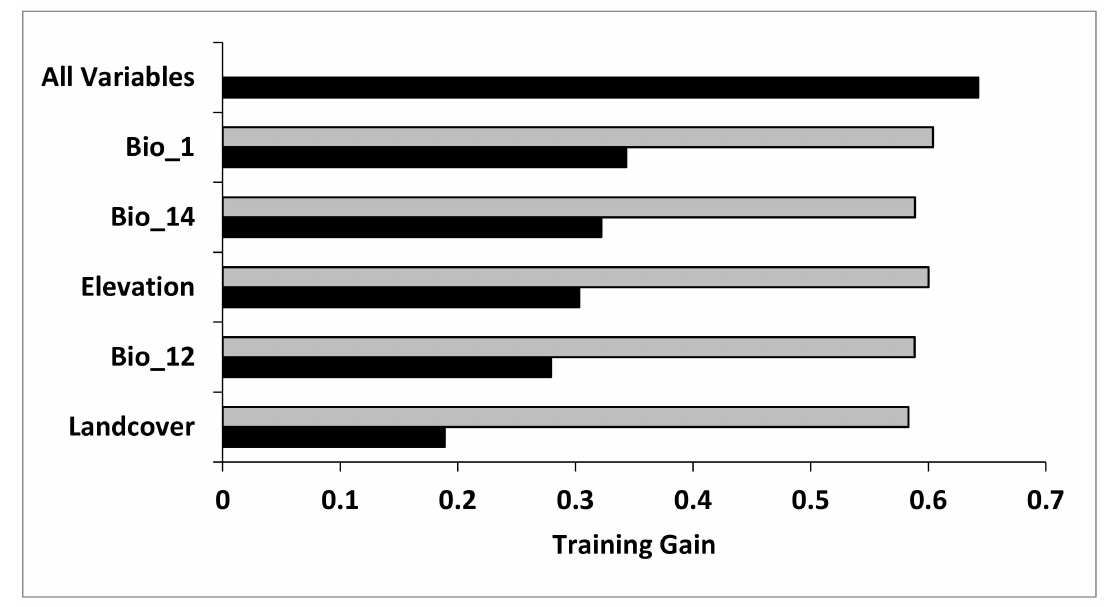
Figure 1. Jackknife test for evaluating the relative importance of predictor variables. (Annual mean temperature (Bio_1), Annual precipitation (Bio_12), Precipitation of driest month (Bio_14)). The average training gain gradually declined as variables were removed (Table 2). Test AUC values were significantly better than random (> 0.5 AUC) for all models (0.76–0.88), suggesting little model over-fitting. Using the overlap between 95% confidence intervals, both the average training gain and the average training AUC pointed to the same model as the most